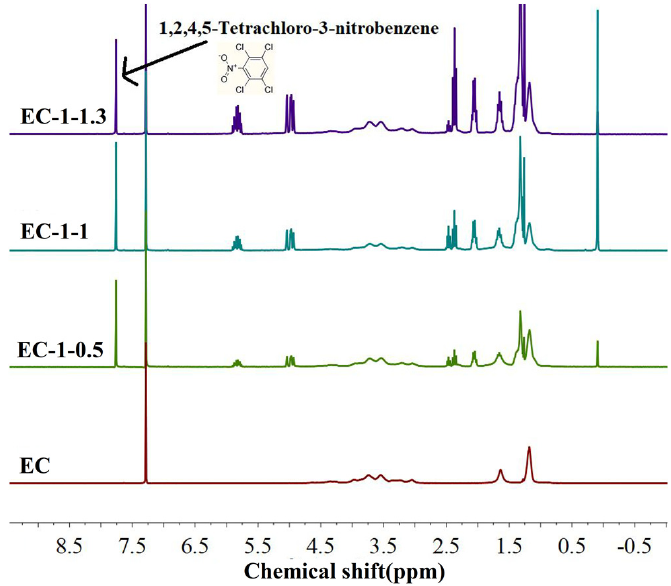
Figure 5. 1 H NMR of OFL with the interior label compared with lignin.